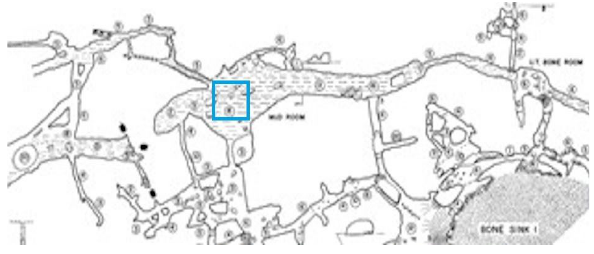
Figure 1. A planar view of the region of Inner Space Cavern where the experiment was